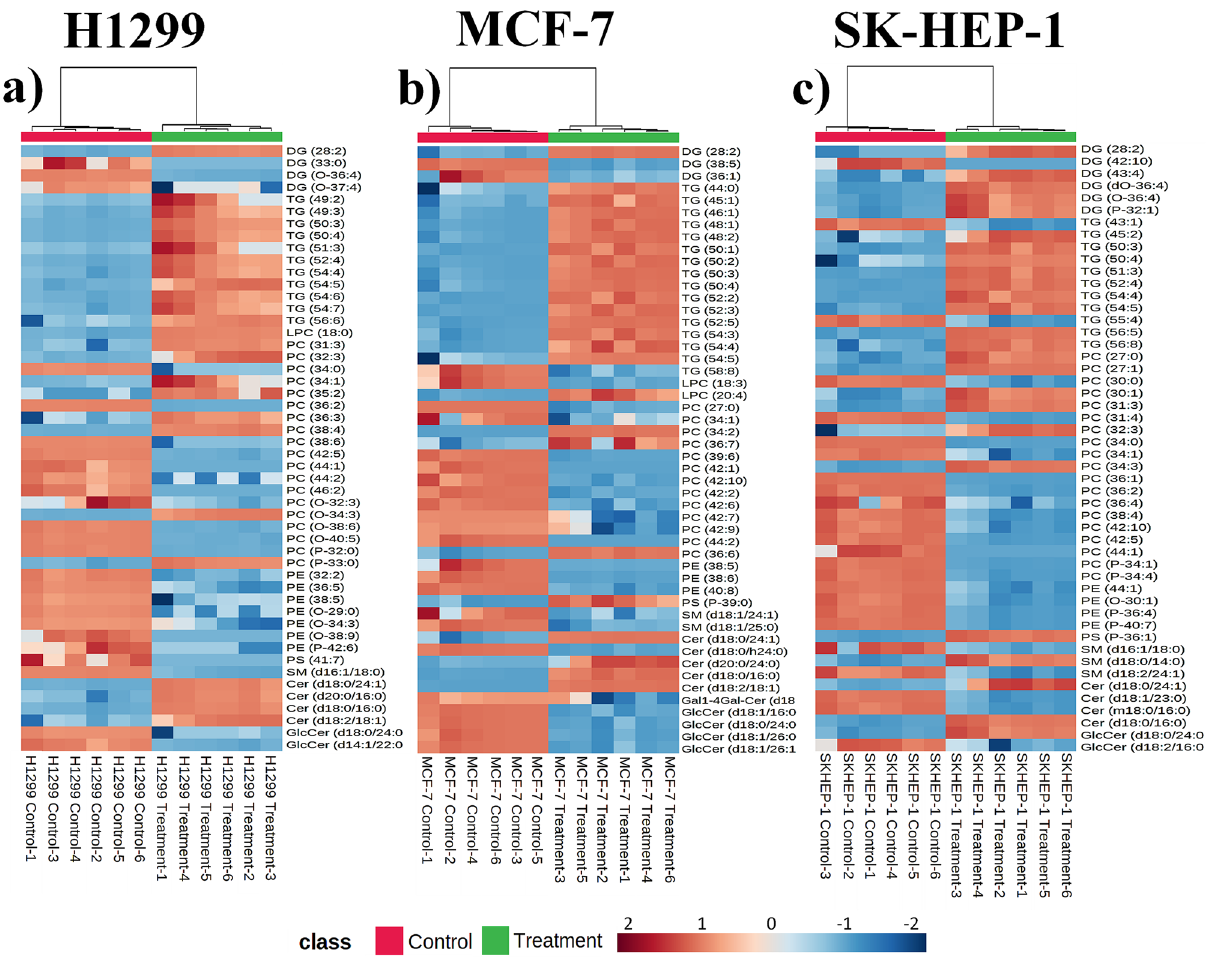
Figure 6. Heat map analysis of the extracted non-polar metabolomes of H1299 ( a ), MCF-7 ( b ), and SK-HEP-1 ( c ) cells analyzed in positive ionization mode. Groups are indicated at the top of each map by red (control, n = 6) and green (treatment [IC 50 R-S5-C1-H1, 48 h], n = 6). The maps show 50 of the most significantly perturbed non-polar metabolites based on Euclidean distances and Ward clustering. The rows represent metabolites, while the columns represent the samples. The metabolite concentrations are represented on a log scale. The scale bar represents the normalized intensity of features. Decreased and increased metabolites are displayed in blue and red,